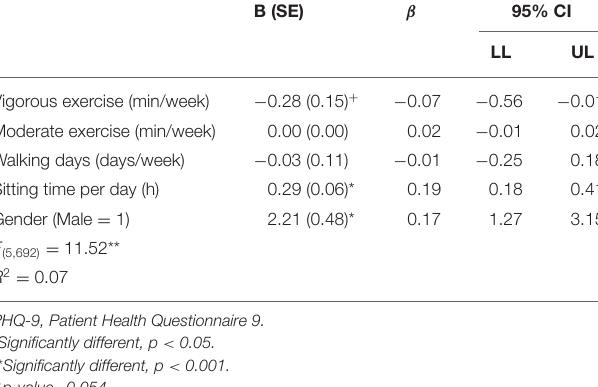
TABLE 2 | Students who reportedly met physical activity weekly MVPA recommendations (reported as either moderate, ≥ 150 min/week); and, or vigorous, ≥ 75 min/week) compared to those that did not meet guidelines.